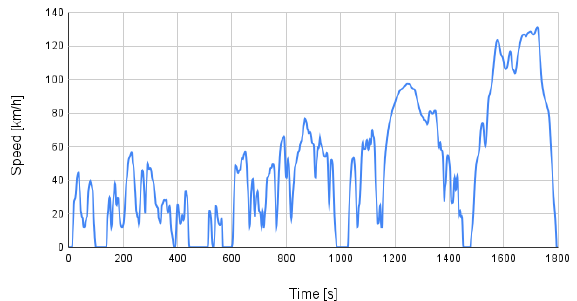
Figure 2. WLTC—Class 3b, Worldwide harmonized Light vehicles Test Cycle consisting of Low, Medium, High and Extra High